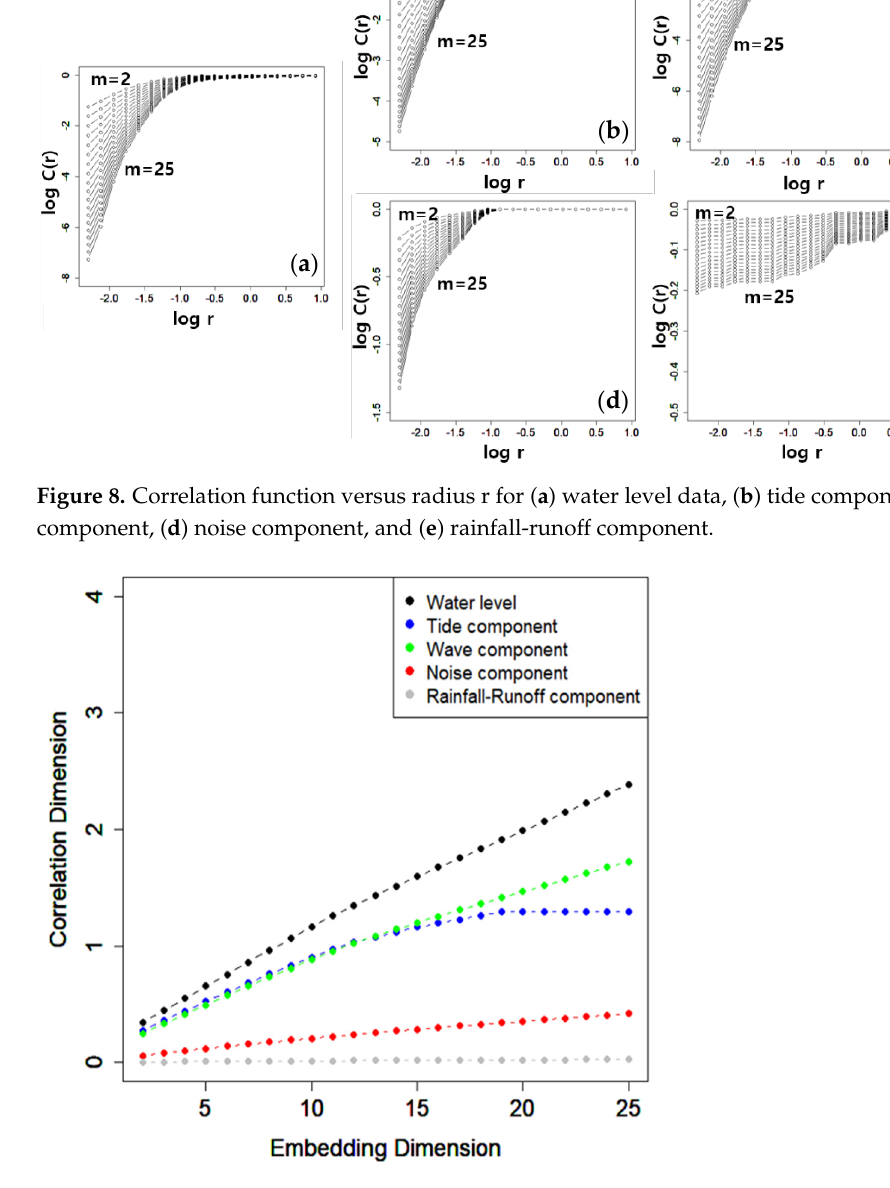
Figure 9. Correlation dimension of each component.